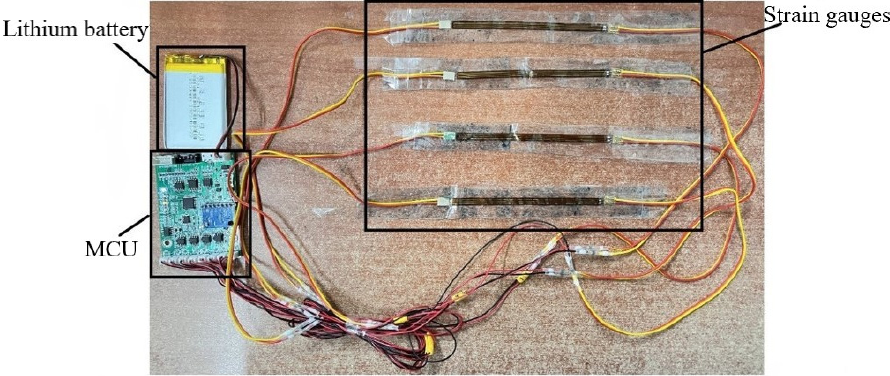
Figure 3. The sleeping - position monitoring device sensor, lithium battery, and MCU.